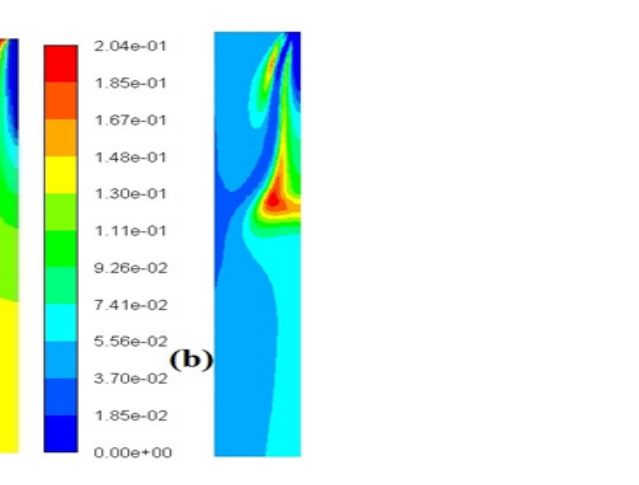
Figure 31. Contours of CO 2 content in mole fraction where the right vertical line represents the axis of symmetry: ( a ) Reactor 1 and ( b ) Reactor 2.